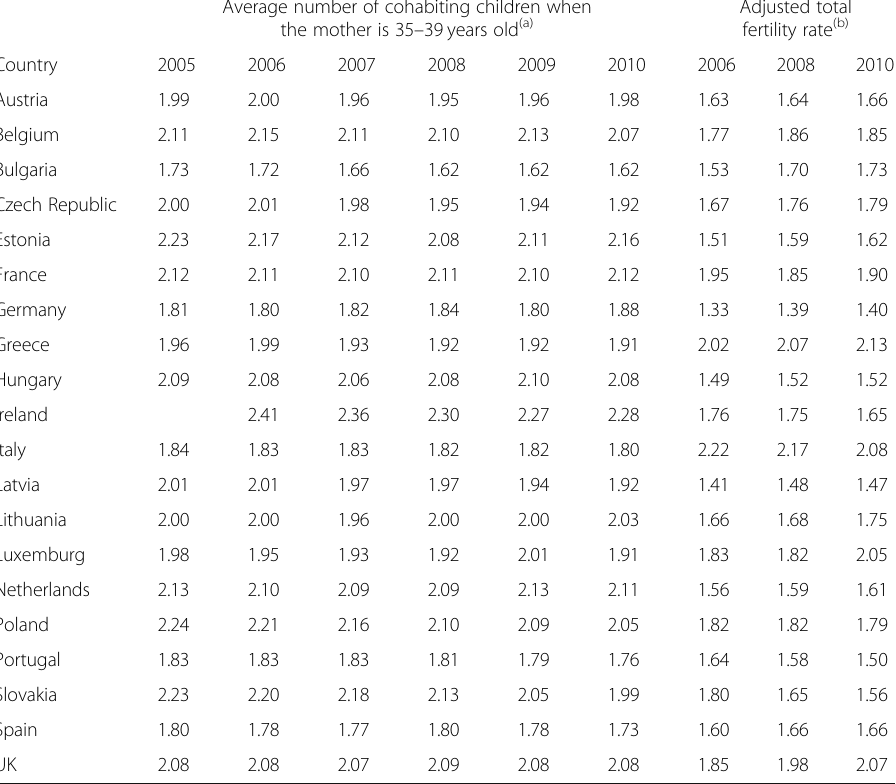
Table 5 The number of cohabiting children in the household when women are 35 – 39 reflect women ’ s total fertility rate